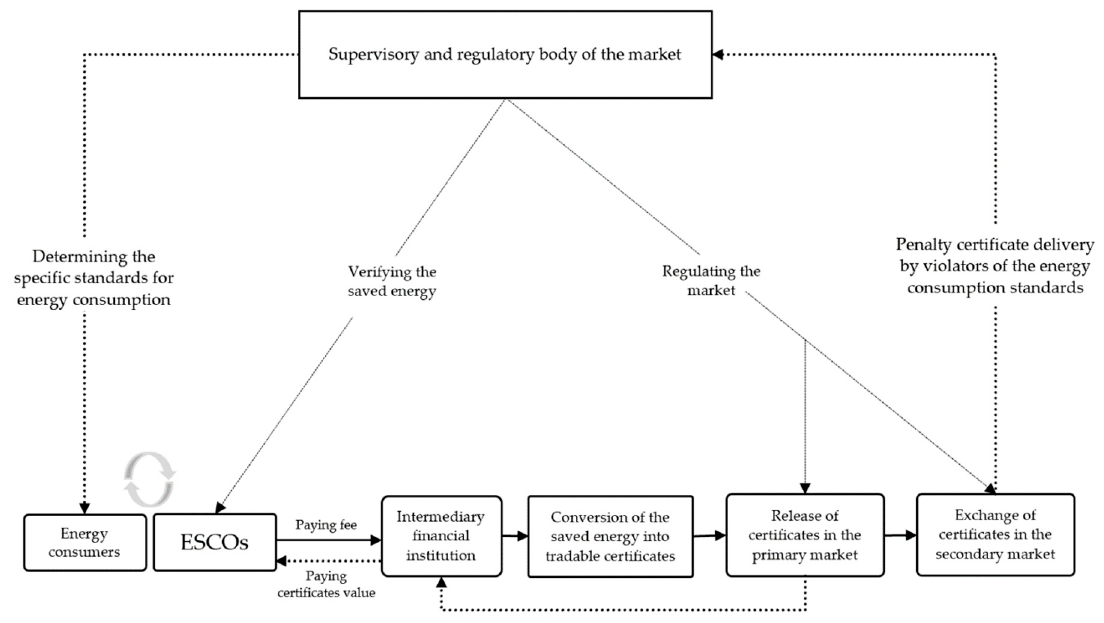
Figure 4. The schematic view of the interactions of ESCO with other members of the ESC market (source: authors conception) .